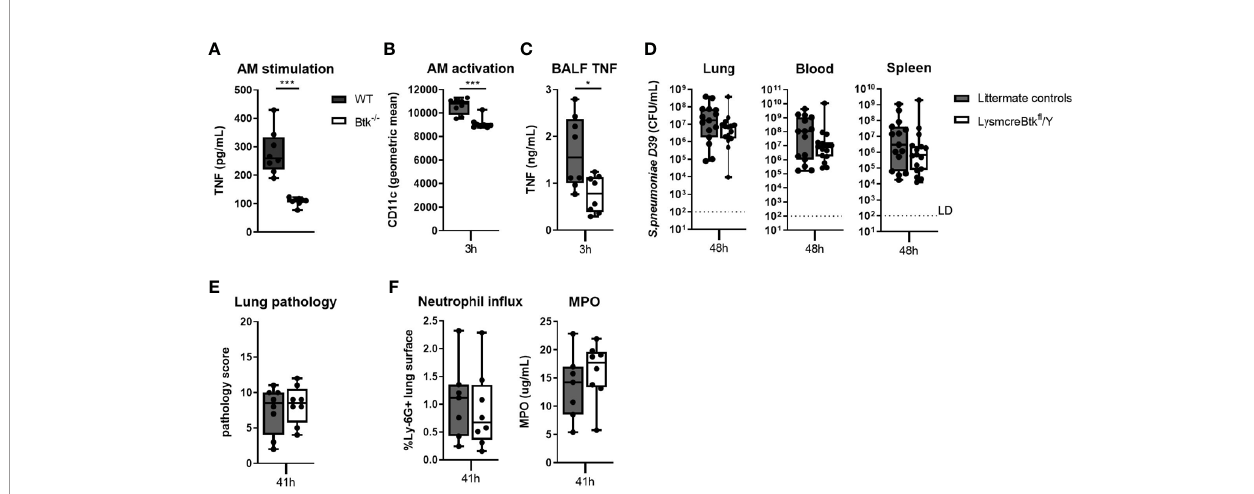
FIGURE 4 | Btk contributes to alveolar macrophage responsiveness to pneumococci but LysM driven de fi ciency of Btk does not in fl uence resistance against bacterial outgrowth during pneumococcal pneumosepsis. (A) TNF levels in supernatant of WT and Btk -/- alveolar macrophages (AM) stimulated for 24 hours with heat killed D39 ex vivo (n=8 per group). (B – E) LysmcreBtk fl /Y mice and littermate controls were intranasally inoculated with 2x10 6 CFU D39 and sacri fi ced after 3 and 48 hours (n=15 per groups). (B) Alveolar macrophage CD11c expression (geometric mean) and (C) BALF TNF levels 3 hours after induction of infection. (D) Bacterial loads in the lung, blood and spleen 48 hours after induction of infection. (E) Pathology score, (F) percentage of Ly-6G positive lung surface and concentrations MPO in lung homogenate 48 hours after induction of infection. Data are expressed as box- and whisker plots showing the smallest value, lower quartile, median, upper quartile and largest value. LD= limit of detection. *p < 0.05, ***p < 0.001, Mann-Whitney U